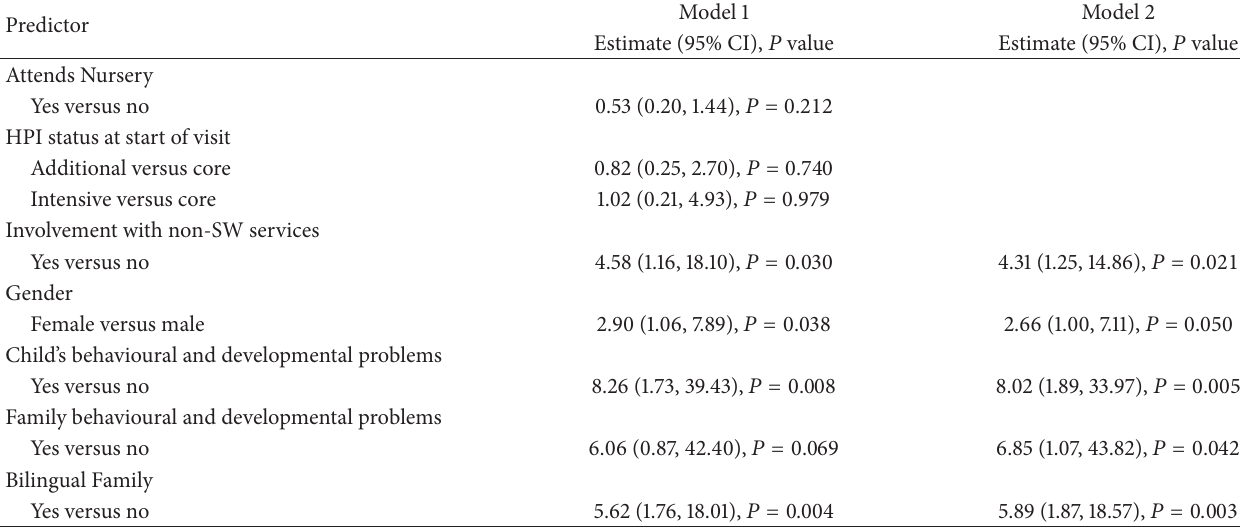
Table 2: Multivariate analysis. Effects of candidate predictor variables, reported as odds ratio for language delay with 95% confidence interval and 𝑃 value.